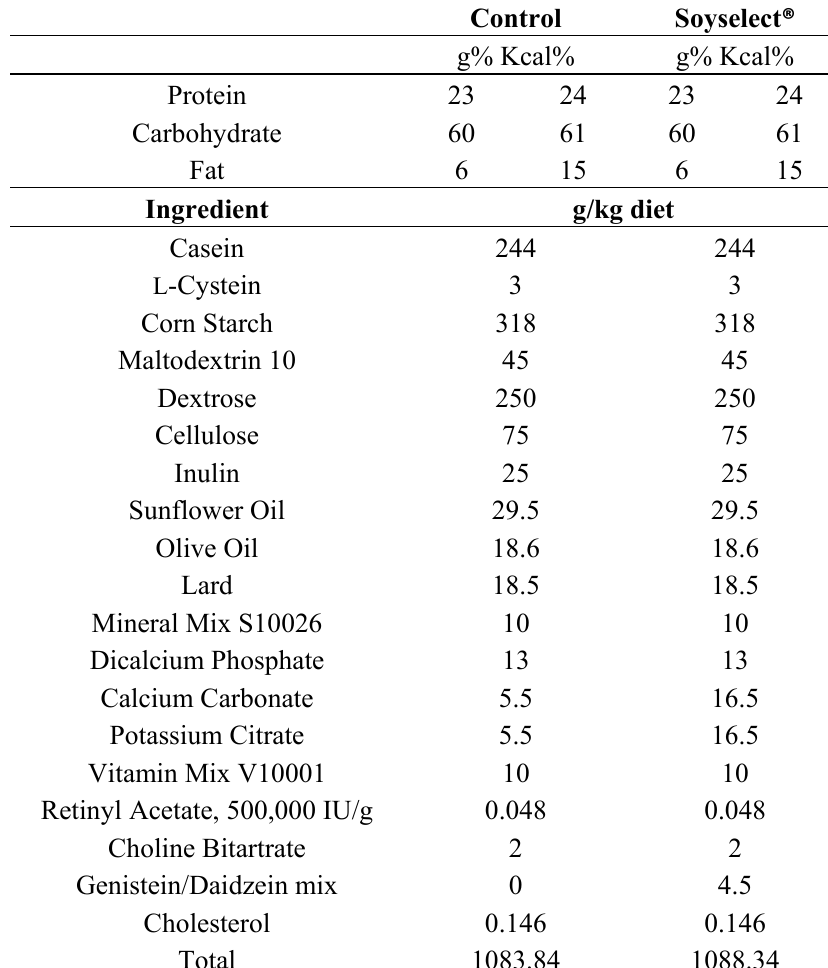
Table 3. Composition of the experimental